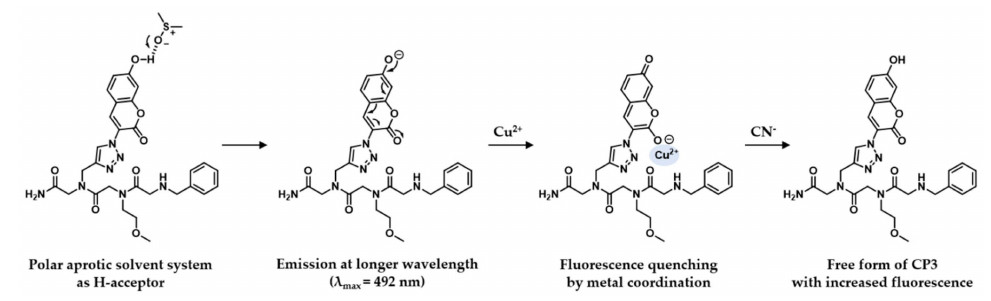
Figure 8. Proposed mechanism underlying fluorescence sensing of coumarin